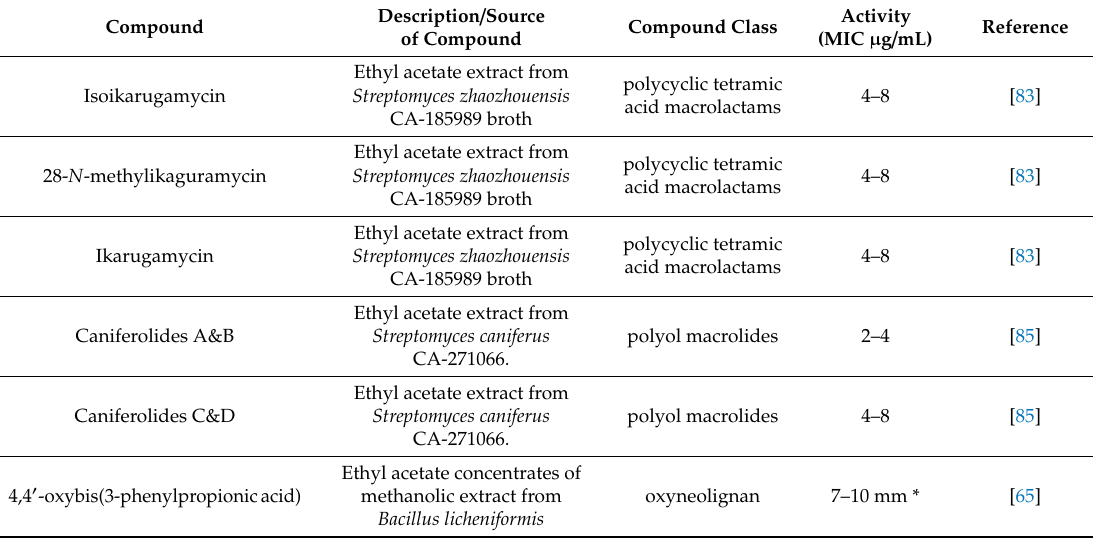
Table 1. Compounds from marine Streptomyces and other bacteria with antifungal activity against A. fumigatus